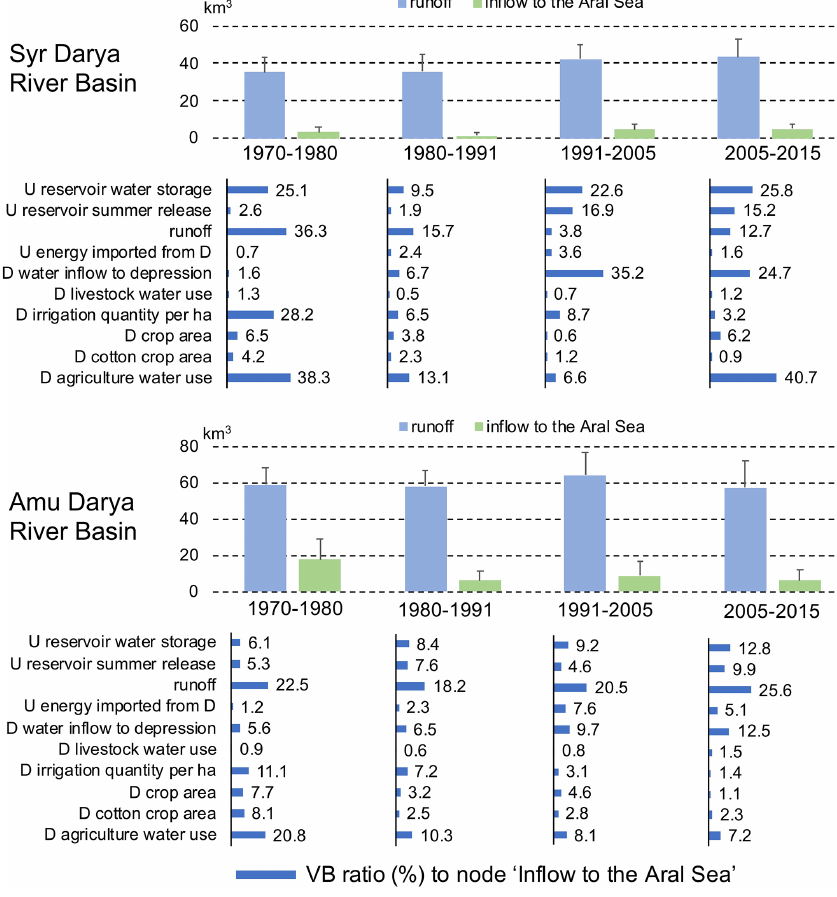
Figure 8. Comparison of the sensitivity analysis of the “water inflow to the Aral Sea” node of the ADB and SDB in four historical periods from 1970 to 2015. D stands for “downstream”; correspondingly, U stands for “upstream”. VB stands for “variance of